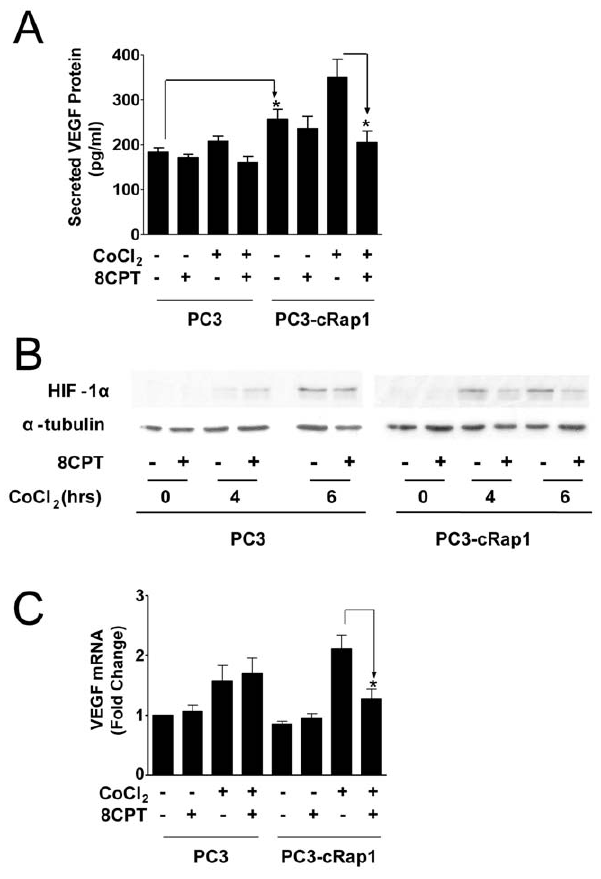
Figure 3. Effect of 8CPT treatment on HIF-1 a and VEGF in PC3 and PC3-cRap1 cells under hypoxic-like conditions. (A) VEGF levels were measured by ELISA in PC3 and PC3-cRap1 cells under hypoxic-like conditions (CoCl 2 ) as described in Methods; *p , 0.05, (n=3). (B) Immunoblot analysis of nuclear extracts from PC3 and PC3- cRap1 cells treated as indicated. HIF-1 a protein levels were determined by immunoblotting with specific antibody; (C) Analysis of VEGF mRNA levels by qPCR in PC3 and PC3-cRap1 cells treated as indicated. Data were normalized to GAPDH levels; *p , 0.05 ( n =3).